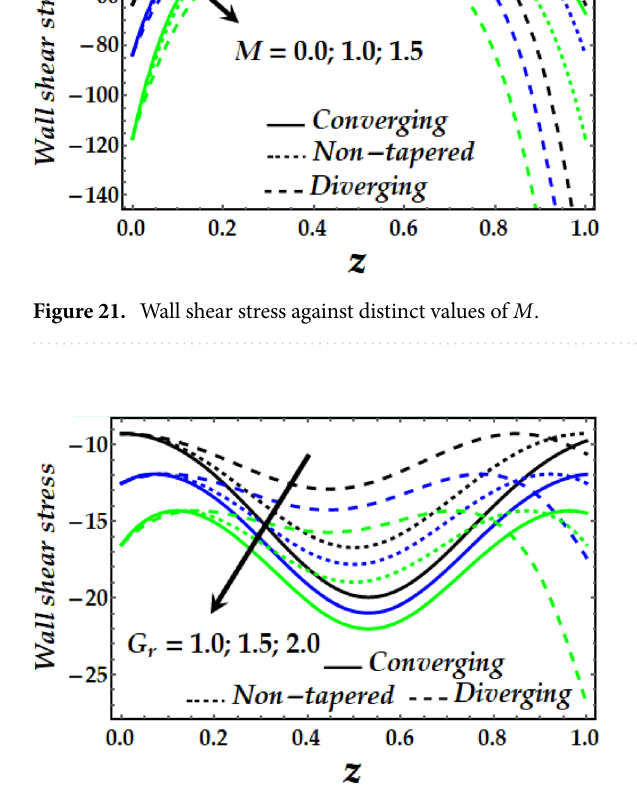
Figure 22. Wall shear stress against distinct values of G r